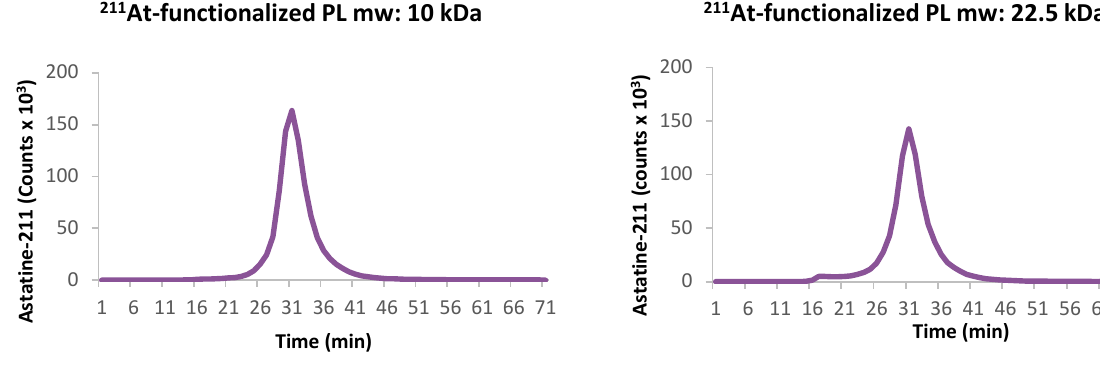
Figure 2. FPLC chromatograms of poly-L-lysine (PL) of 10 kDa (on the left) and 22.5 kDa (on the right), showing UV absorbance at 225 nm of succinylated PL (PLsuc) (orange); UV absorbance at 280 nm of PL functionalized with m-MeATE, H-Tz, and succinic anhydride (green); and the radioactive peak of 211 At-functionalized PL (violet). Phosphate-buffered saline (PBS) was used as the mobile phase. Table 2. Specific activity of astatinated poly-L-lysine (PL) effector molecules of different molecular weights (large PL: 21 kDa and small: 10